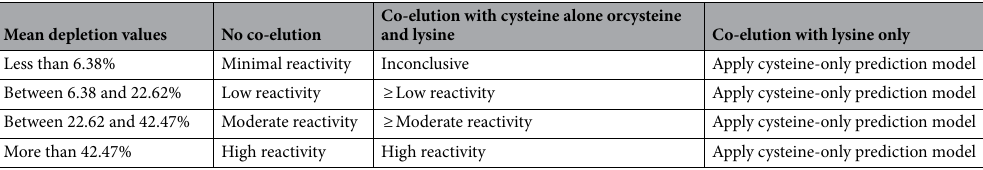
Table 6. The different scenarios possible and recommended